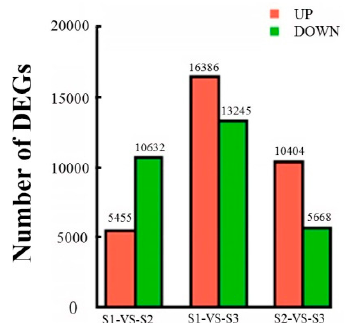
Figure 5. Analysis of differentially expressed unigenes (DEGs) during flowering in O. fragrans are listed with different comparisons, including S1versusS2, S1versusS3, and S2versusS3. Red indicates up-regulated unigenes, while green indicates down-regulated unigenes. The x -axis indicates the absolute expression levels (Log Conc). The y -axis indicates the log-fold changes between the two samples.